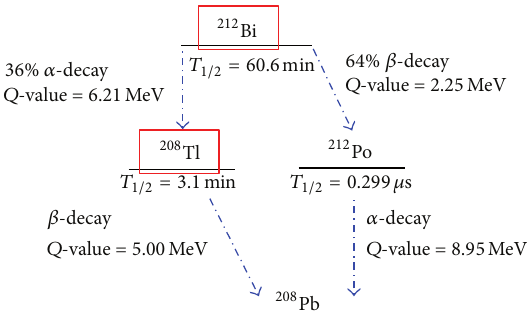
Figure 4: Part of 232 Th-decay chain relevant for SNO+ with 𝑄 - values, half-life, and decay modes [24]. The red squares highlight the most important nuclides: 212 Bi and 208 Tl. The decays used for 𝛼 - 𝛽 and 𝛽 - 𝛼 coincidence techniques are shown with a blue arrow (dash-dotted